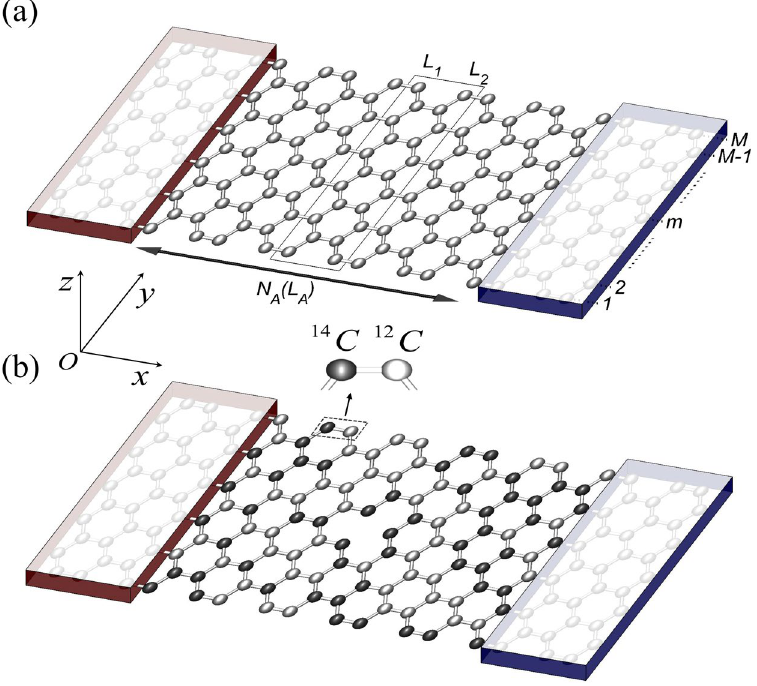
Figure 1. Schematic view of devices made of armchair graphene nano-ribbons. ( a ) Pristine 12 C structure without disorders, the width of ribbons is characterized by the number of dimer lines M , and the active region contains N A unit cells with the length L A . ( b ) The active region includes a fraction of isotope 14 C doping and a vacancy at position m =